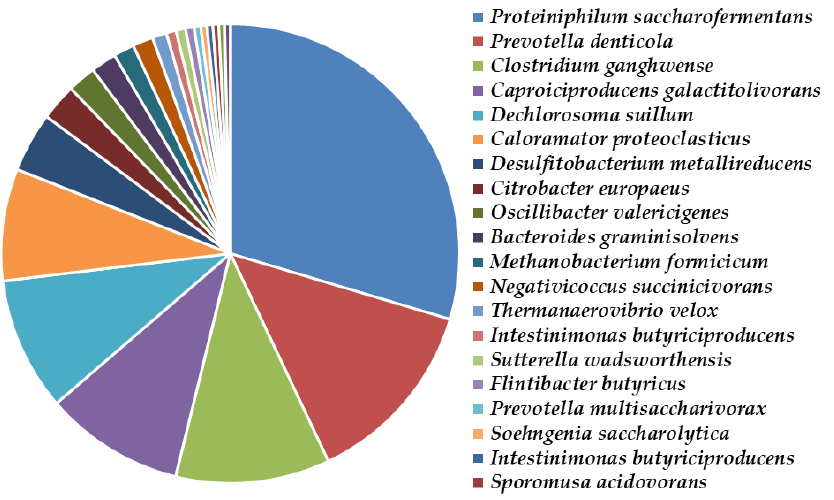
Figure 11. Species diversity in the methane-producing microbial consortium inhabiting the second bioreactor. The isolation of this species from an anaerobic mesophilic two-phase biogas reactor (fed with 95% maize silage and 5% wheat straw) was reported by Hanke et al. [38]. The strain P. saccharofermentans M3/6T produced acetate, propionate, and iso-valerate as vola- tile fatty acids, and carbon dioxide, hydrogen, acetate, formate, propionate, and iso-val- erate as end-products of the fermentation process, suggesting that its function in the bio- gas production process is associated with the acidogenic phase [39]. It is known that P. saccharofermentans produces extracellular enzymes involved in the degradation of com- plex carbohydrates (β -glucan, xylan, arabinoxylan, starch, arabinogalactan, phosphoric acid-swollen cellulose (PASC), and carboxymethyl cellulose). According to the NCBI da- tabase, the P. saccharofermentans strain M3/6T contains various genes encoding carbohy- drate-active enzymes, which are involved in the decomposition of pectin, arabinogalac- tan, hemicellulose (arabi nan, xylan, mannan, and β -glucans), cellulose, starch, fructan, chitin, and pullulan [39]. Strain M3/6T is also able to degrade xylose, lyxose, mannose, and melibiose, as well as some amino acids (e.g., proline, alanine, and asparagine) to py- ruvate [40]. The majority of the metabolites are converted to pyruvate [40]. All these abil- ities indicate that the species P. saccharofermentans increases biogas production. The reductive acetogen Proteiniphilum acetatigenes was detected only in the methane- producing consortium and comprised 4.7% of the bacterial community (Figure 10). This species produces acetic acid from yeast extract, peptone, pyruvate, and L-arginine fer- mentation, as well as propionic acid and is known to increase methane production [41,42].